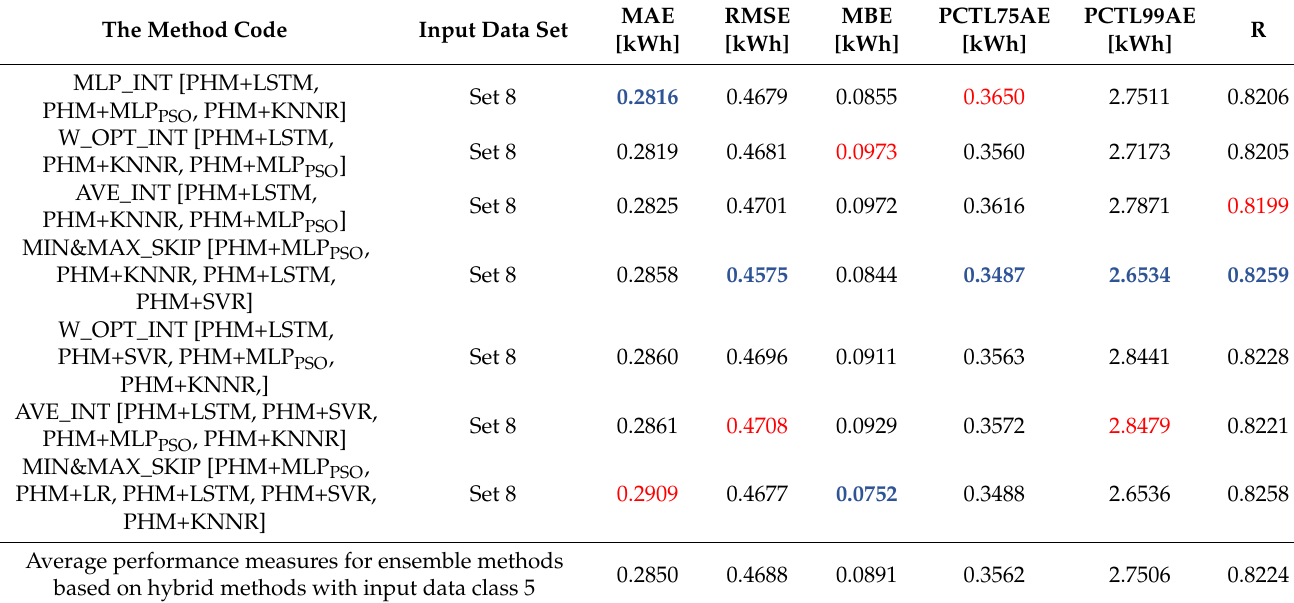
Table 12. Performance measures for ensemble methods based on hybrid methods with input data class 5. The Method